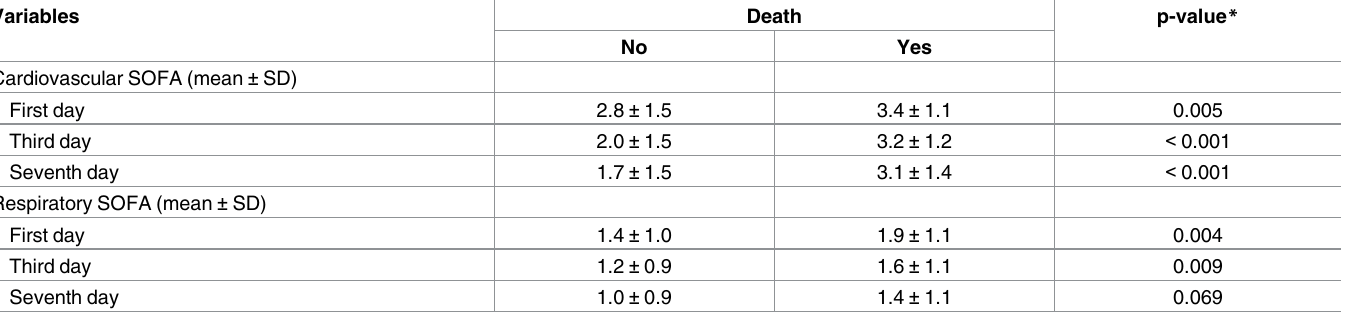
Table 5. Comparison between cardiovascular and respiratory SOFA components on the first, third, and seventh days of dialysis and mortality.